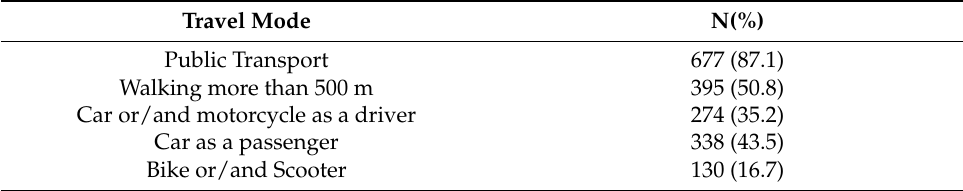
Table 5. Travel preference of sample’s responders (N =